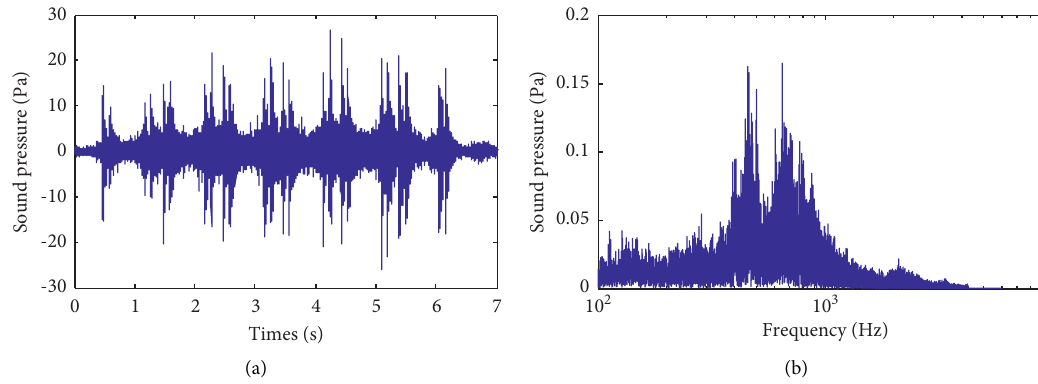
Figure 2: Sound pressure of urban railway: (a) time domain and (b) frequency domain.